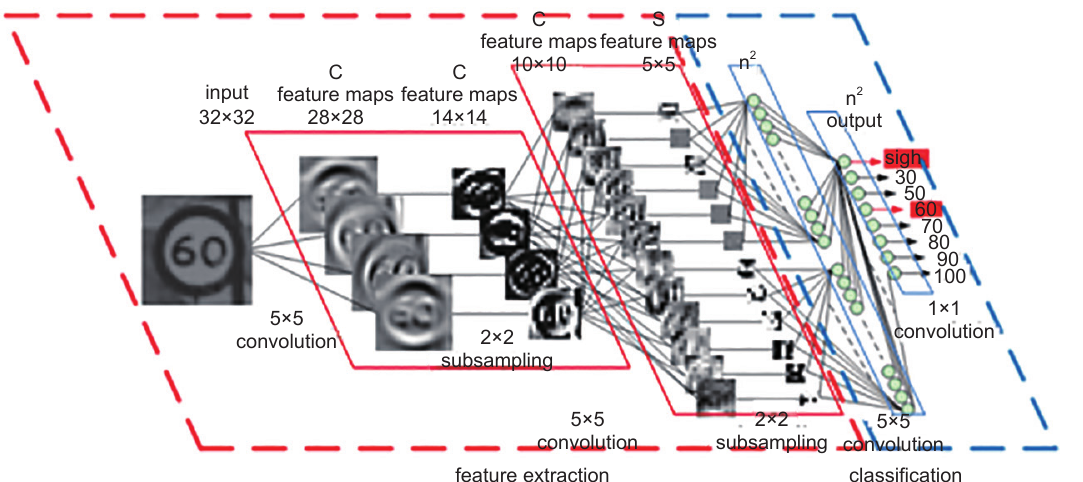
Figure 2 An example of showing that an input image is filtered by convolutional layer then creates 4 feature maps. Max pooling is utilized to subsampling these feature maps. Then the process ran again from convolutional layer and finally all generated features are combined in fully connected layer for classification. (Reprinted with permission from